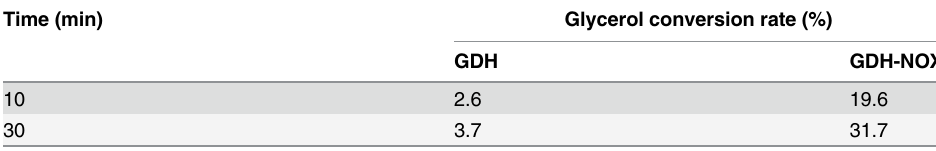
Table 5. Bioconversion of glycerol by GDH and GDH-NOX. Time